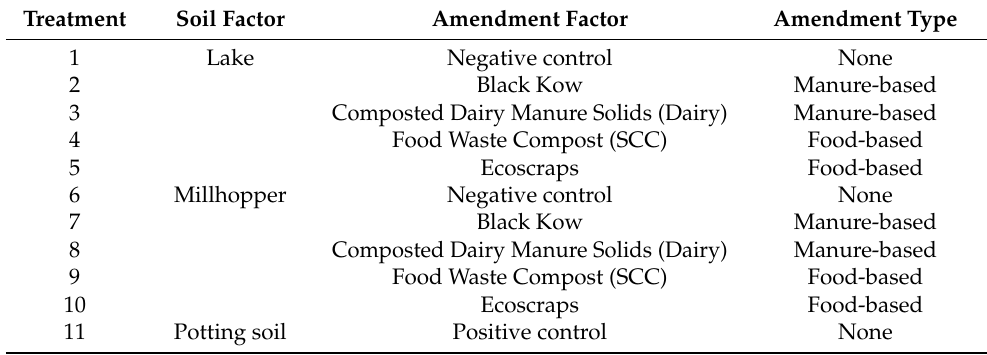
Table 1. Treatments employed in this experiment, generated by the combination of the soil and amend- ment factors. Potting soil is shown in this table although it was not included in statistical analyses. Treatment Soil Factor Amendment Factor Amendment Type 1